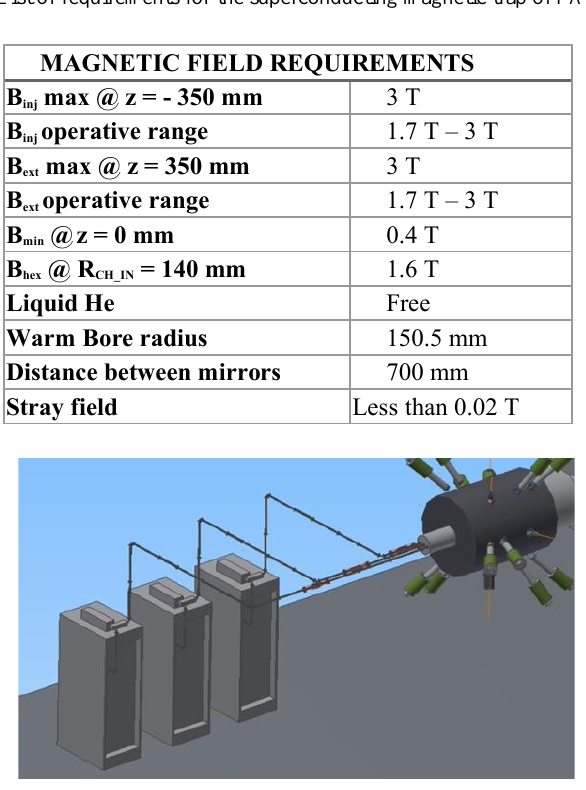
Fig. 1 – Final design of the magnetic superconducting trap (on the left), with details about the hexapole structure and the radial holes in the plasma chamber made to allow gamma-rays to be detected by the HPGe detectors surrounding the trap. Tab. 1 – List of requirements for the superconducting magnetic trap of PANDORA.